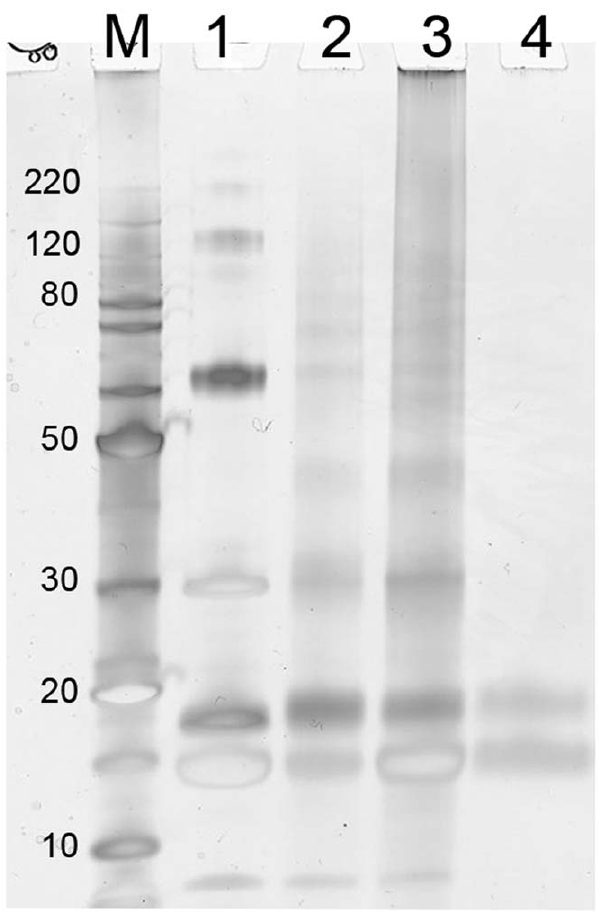
Figure 1. Elevated pressure improves protein extraction from model FFPE tissue surrogates. FFPE tissue surrogates were heated in 50 mM Tris, pH 8 + 2% SDS at either elevated pressure (40,000 psi) or atmospheric pressure. The electrophoretic mobility of the tissue surrogate extracts were compared to the native, unfixed tissue surrogate mixture by 1D-PAGE. Lane M: molecular weight marker; lane